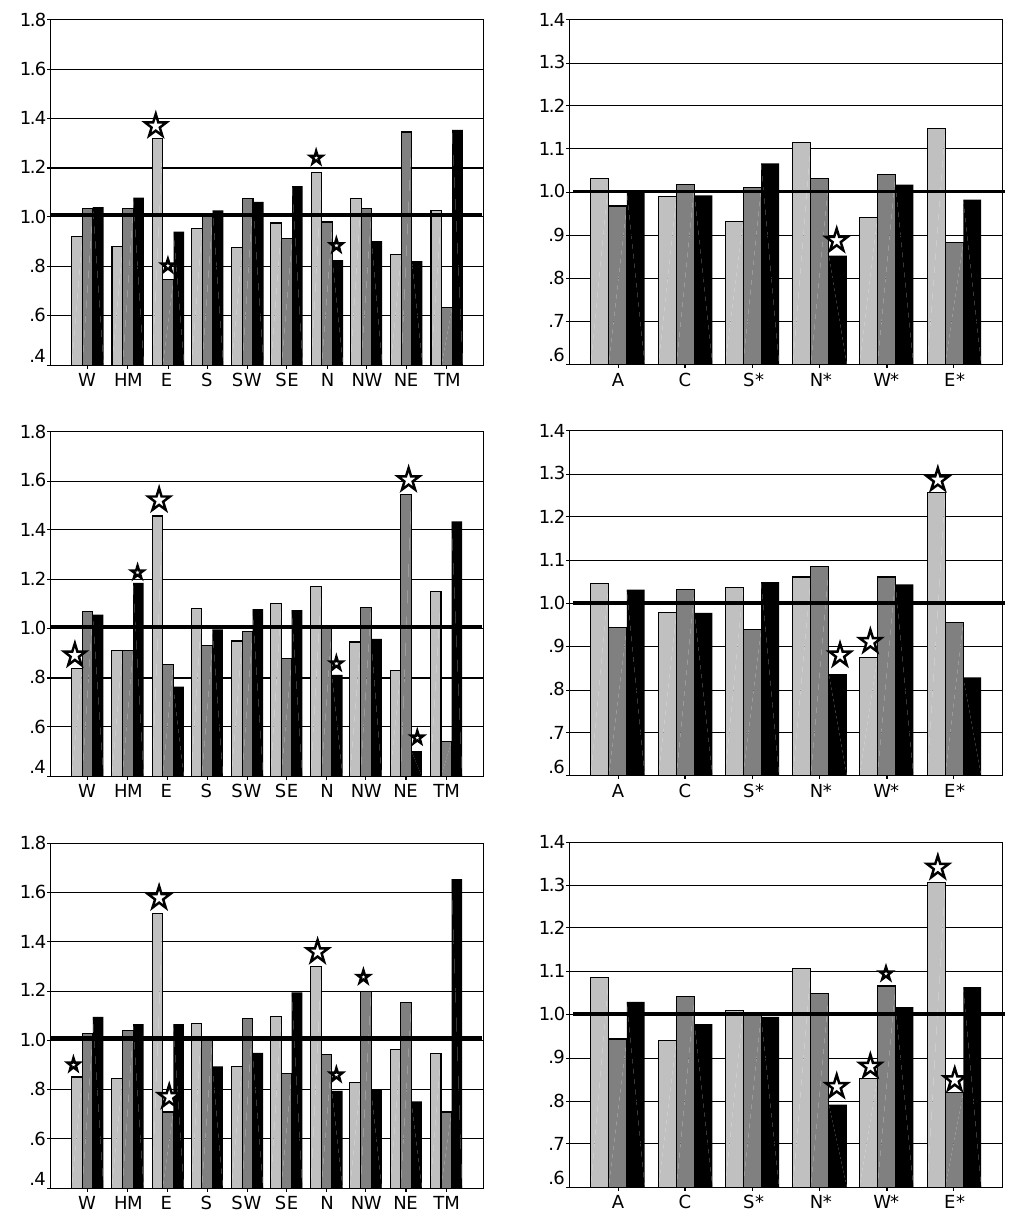
Huth et al., Fig. 2